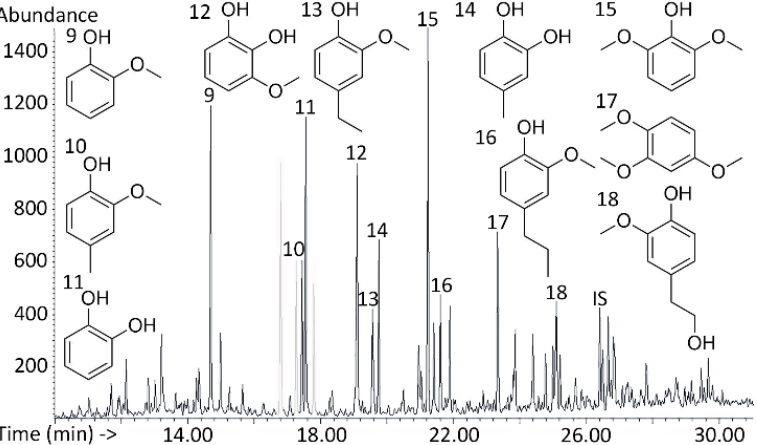
Figure 2. Chromatogram of the oil from experiment HW1-wetox-360. Peaks from impurities in the solvent are in grey. Internal standard (IS) is hexadecane.